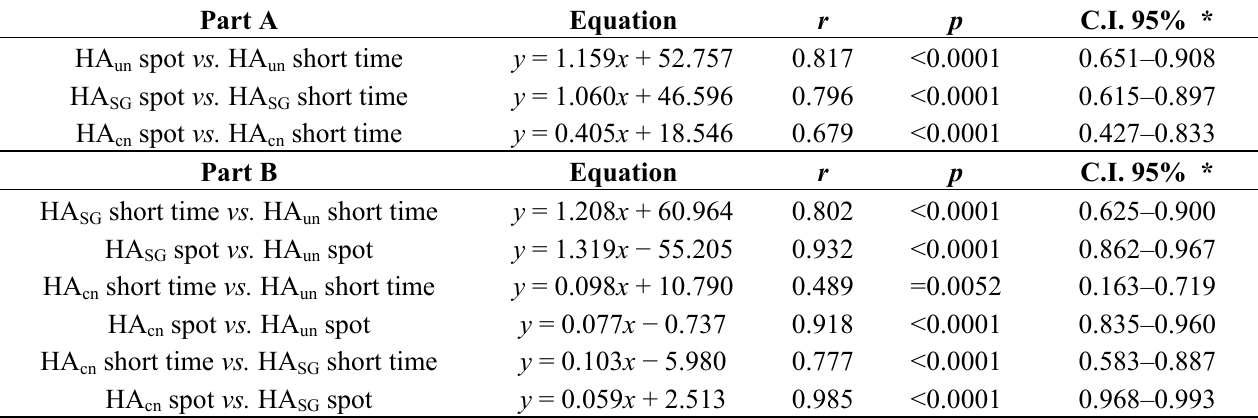
Table 2. Correlation between HA excretion in spot and short-term urine samples unadjusted or adjusted to SG or